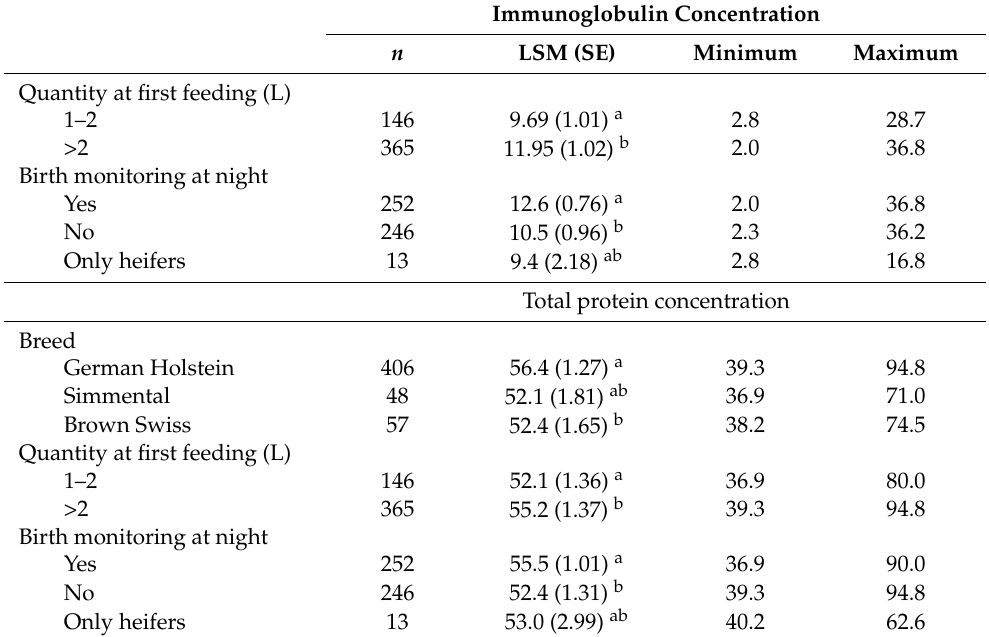
Table 5. Least squares means (LSM) (SE), minimum and maximum of immunoglobulin and total protein concentration from the final model, measured in serum of 511 calves between March 2017 and March 2018, regarding breed, quantity at first feeding of colostrum and birth monitoring at night. Immunoglobulin Concentration n LSM (SE) Minimum Maximum Quantity at first feeding